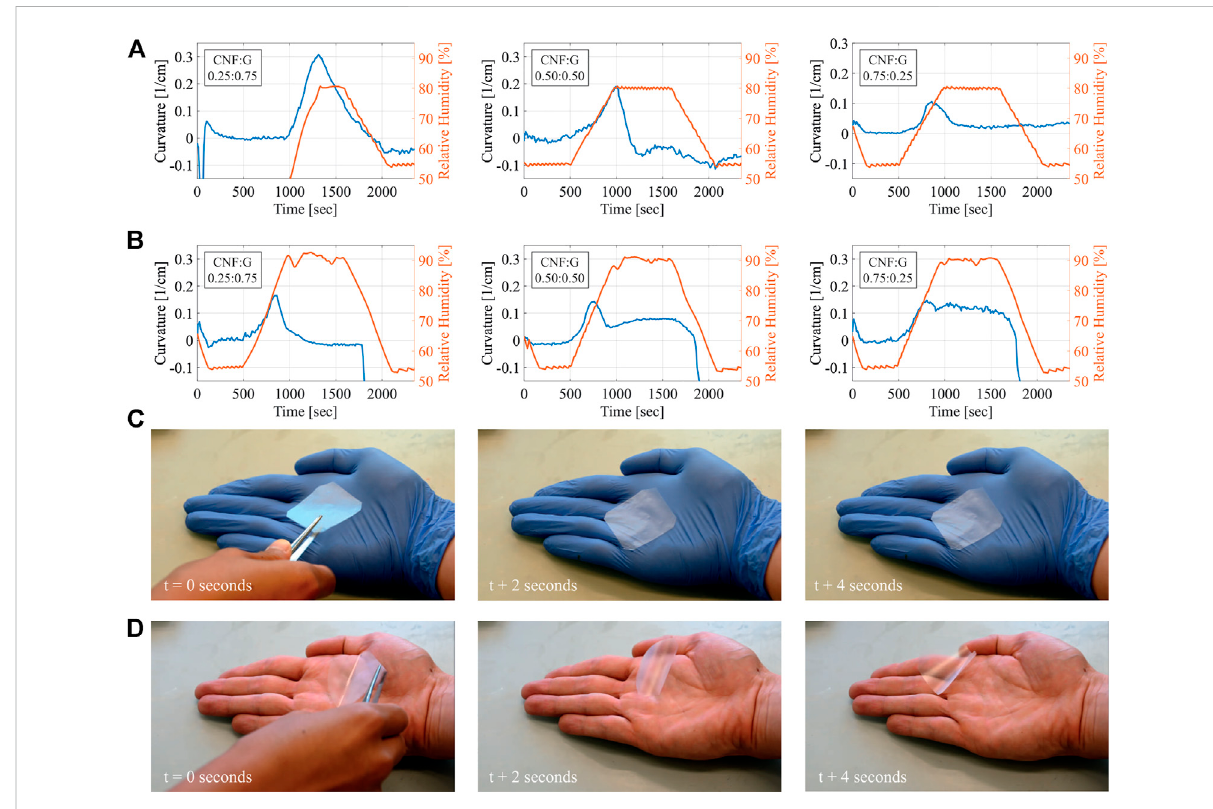
FIGURE 7 Summary of the humidity responsive fi lm tests. To achieve quantitative values the curvature of a 1 cm by 3 cm large fi lm was measured, while the relative humidity was varied from 55% to 80% and from 55% to 90% at a constant temperature of 20 ° C. Additionally, the fi lm ’ s ability to react to humidity coming from the skin was qualitatively visualized. (A) gives the curvature versus relative humidity of the CNF:G — 0.25:0.75, CNF:G — 0.50: 0.50and CNF:G — 0.75:0.25 fi lm between 55% and80%, (B) gives thecurvatureversusrelativehumidity oftheCNF:G -0.25:0.75, CNF:G — 0.50: 0.50 and CNF:G — 0.75:0.25 fi lm between 55% and 90%, (C) gives a photograph of the CNF:G — 0.25:0.75 fi lm placed on a hand wearing a glove after 0, 2 and 4 s, (D) gives a photograph of the CNF:G — 0.25:0.75 fi lm placed on a bare hand after 0, 2 and 4